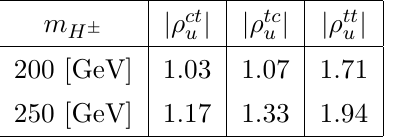
is (cid:12)xed at H +